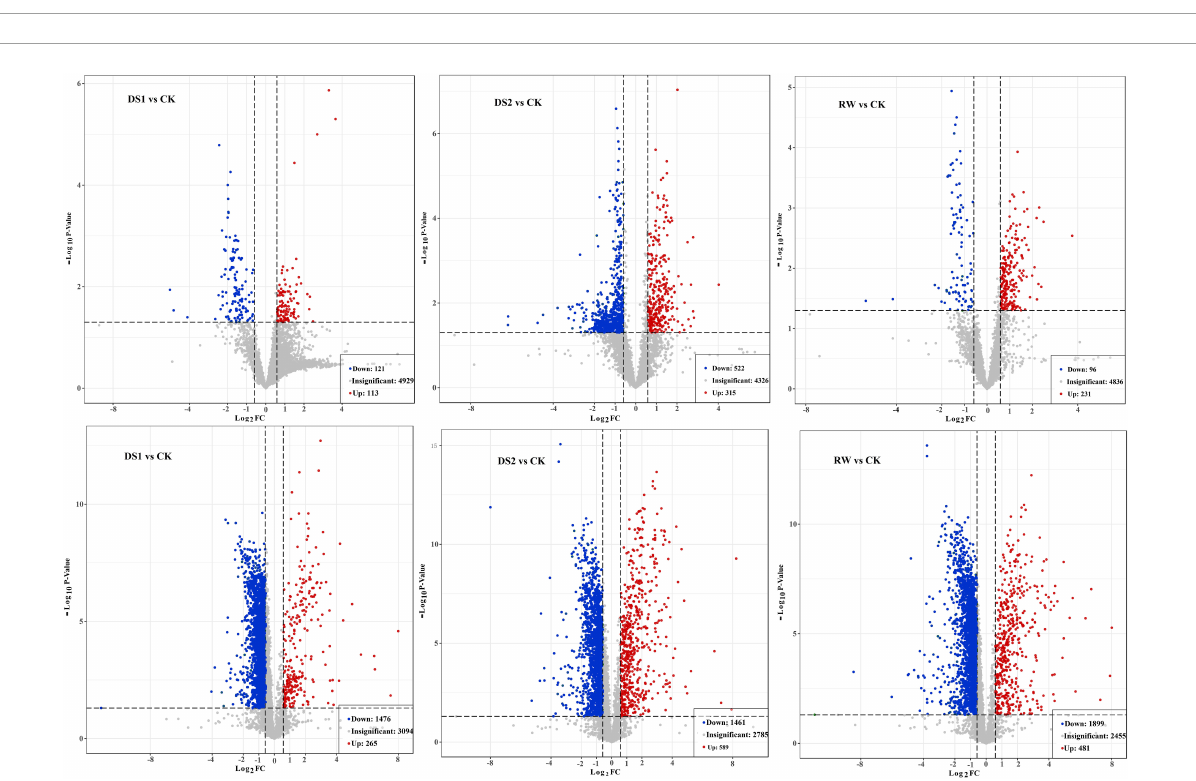
FIGURE4 Volcano plot on LC-MS based metabolites that were significantly different in DS1 vs CK, DS2 vs CK, and RW vs CK comparisons in positive (upper) and negative (lower) ion modes, respectively. The red color indicates metabolites with fold change ≥ 1.5 and p value ≤ 0.05. The blue color indicates metabolites with fold change ≤ –1.5 and p value ≤ 0.05. The gray color indicates metabolites with no significant difference.